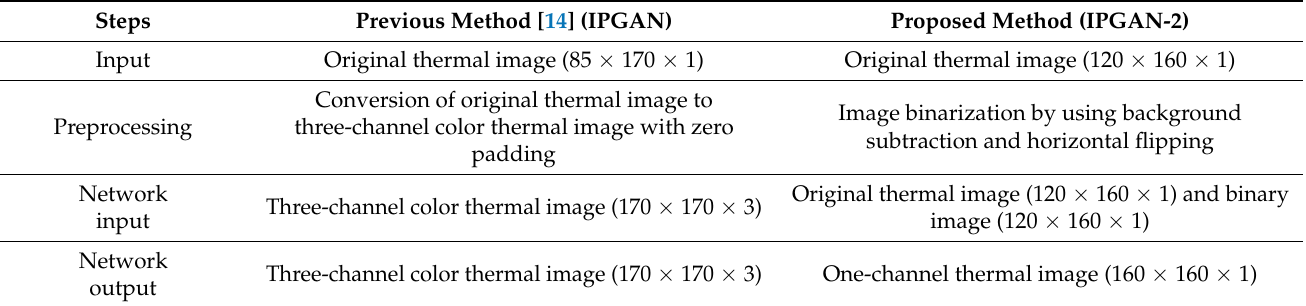
Table 9. Comparison of overall structure of previous method [14] and proposed